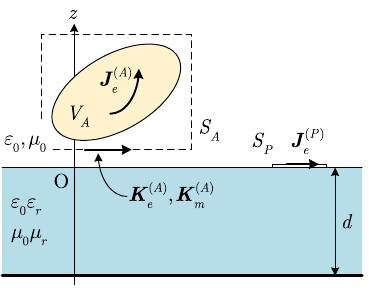
Fig. 8. Equivalent sources.